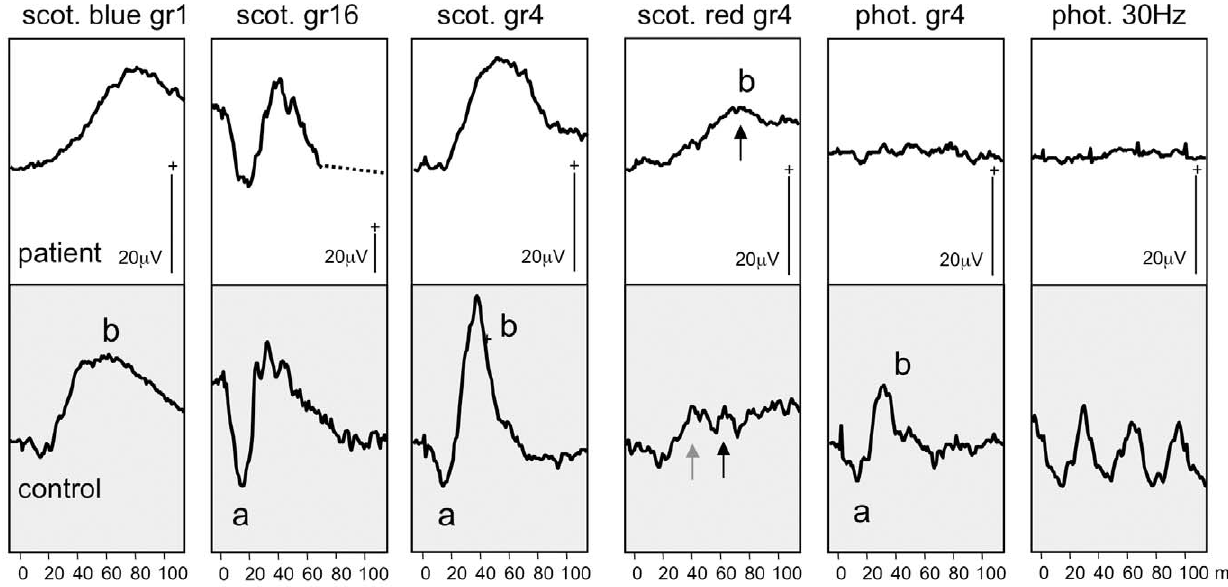
Figure 2. Scotopic and photopic ERG recordings of patient case 7. ERGs recorded from case 7 aged 14 months, using skin electrodes to a range of flash strengths (Grass (gr) 1–16) presented scotopically and photopically are shown above age-matched control data in the lower grey panel. These ERGs indicate cone photoreceptor dysfunction; evidenced by markedly reduced photopic cone and 30 Hz flicker ERGs, and a scotopic red flash ERG that shows predominance of the later rod dominated b-wave (arrowed). The scotopic (gr4) mixed rod cone waveform lacks an a-wave and the time to peak is increased. In contrast predominantly rod mediated function is within the normal range; evidenced by the normal a-wave to a maximal scotopic flash and rod driven b-wave to a scotopic dim blue flash.